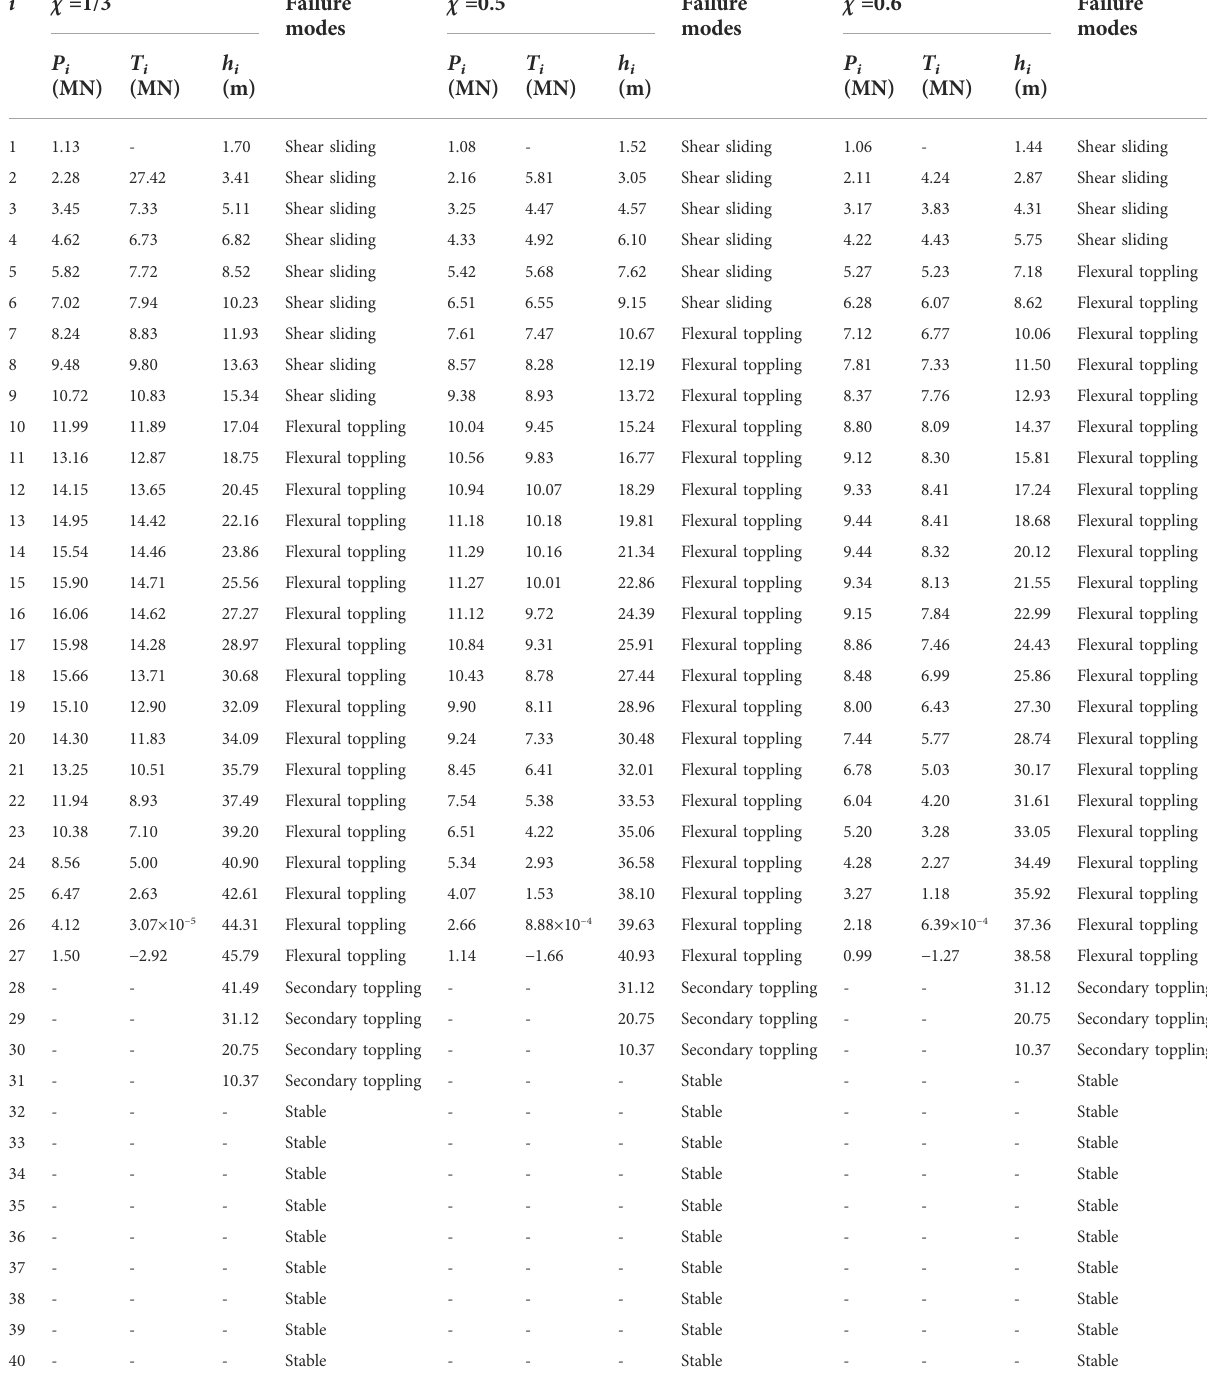
TABLE 4 The externalforces prompting the rock layers to undergo shear sliding failureand fl exuraltopplingfailure, the failuredepths and the failure modes of the rock layers obtained through the presented framework for different values of χ